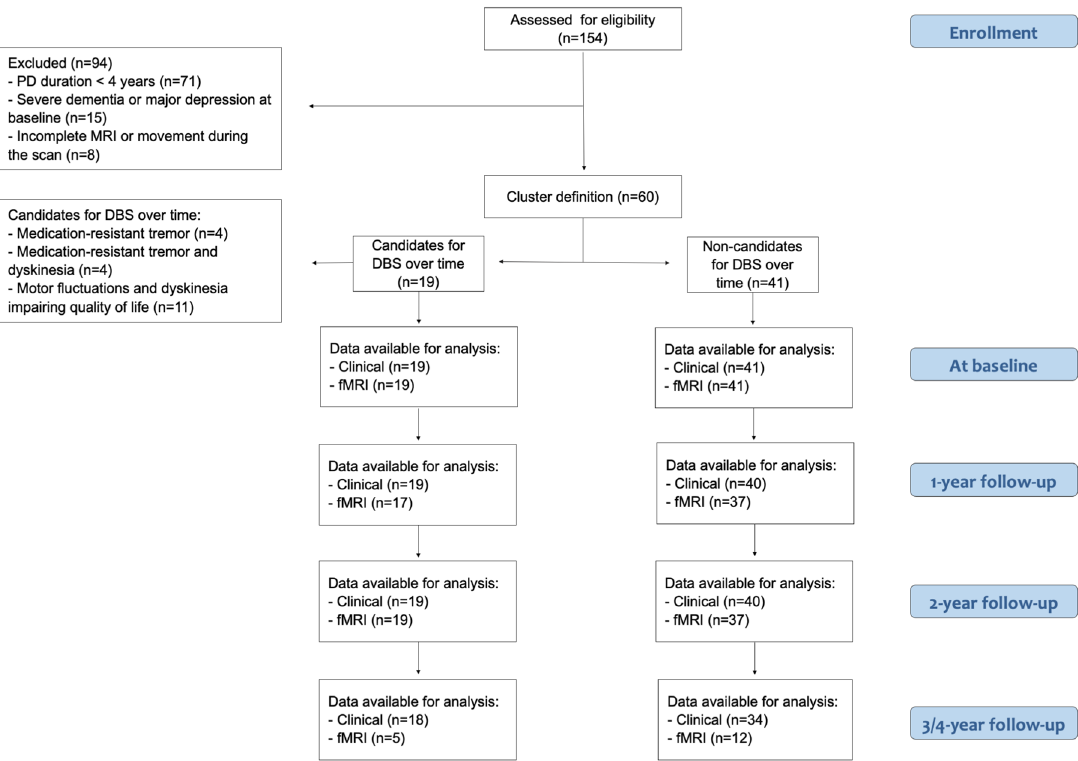
Fig. 1 Flowchart illustrating the inclusion/exclusion of participants in the study. Chart data for 154 patients with idiopathic Parkinson ’ s disease (PD) prospectively recruited at the Clinic of Neurology, Faculty of Medicine, University of Belgrade, Belgrade, Serbia. According to inclusion and exclusion criteria, 60 patients were included in the study. The study cohort was then divided in two groups: 19 patients eligible for DBS treatment and 41 patients who did not meet the criteria to undergo DBS over time. Patients were assessed by clinical, cognitive/ behavioral, and brain MRI evaluations at study entry and every year for a maximum of 4 years. DBS deep brain stimulation, fMRI functional MRI, PD Parkinson ’ s